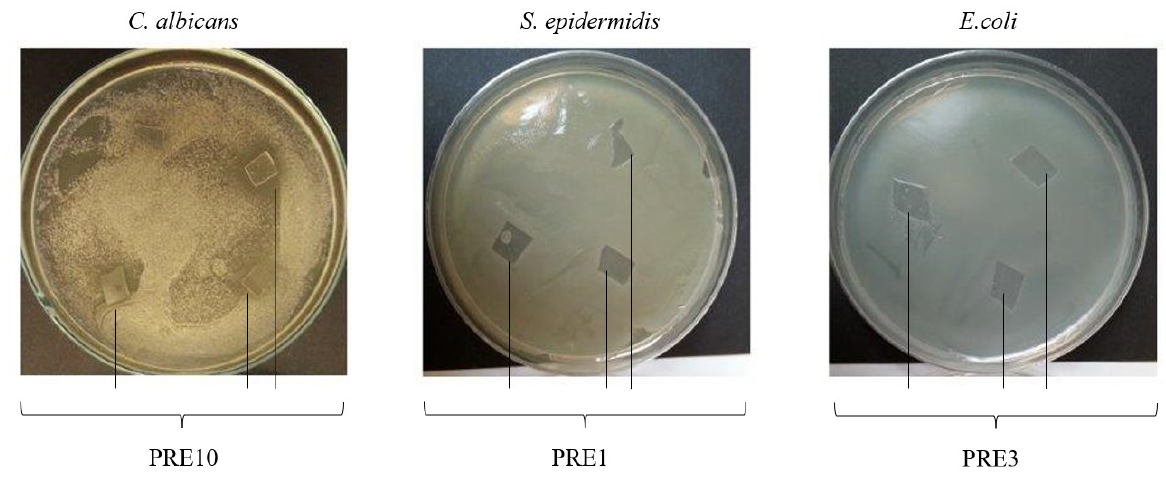
Figure 6. The cured coatings on substrates with antimicrobials.